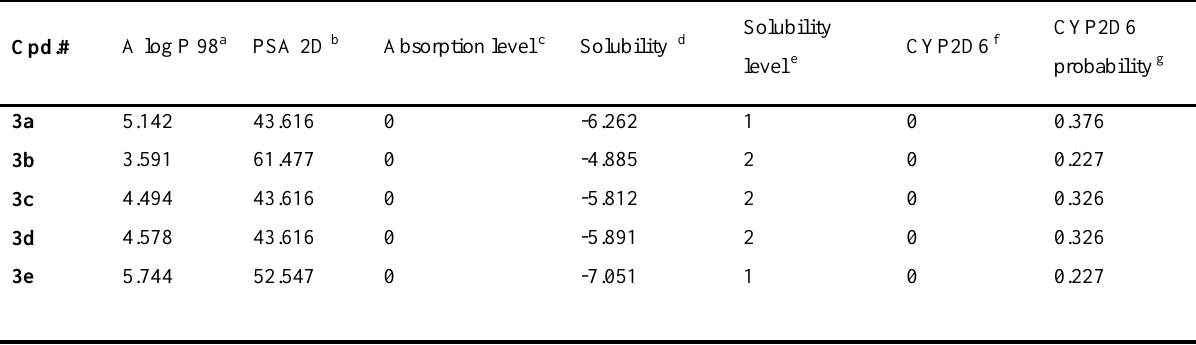
Table 2. Results of in-silico ADME